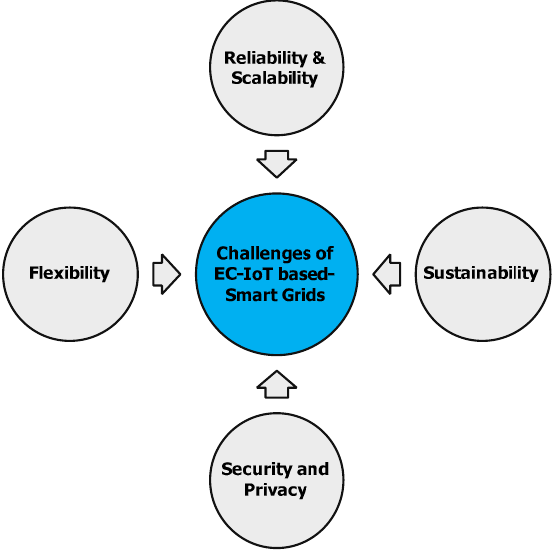
Figure 6. Challenges of EC–IoT-based smart grids.